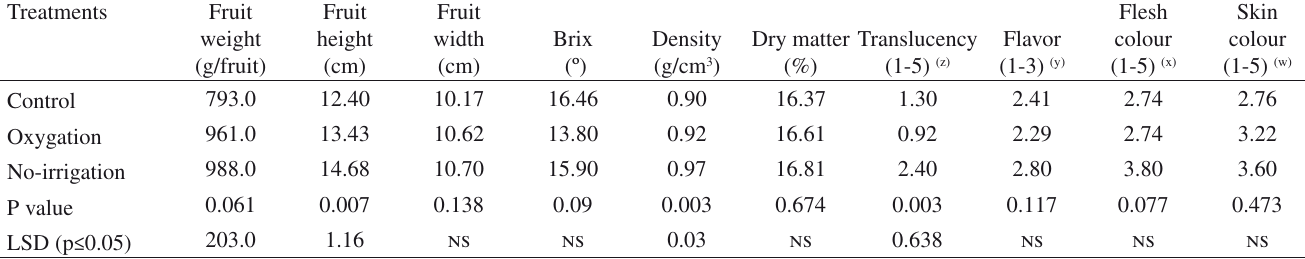
Table 10 - Fruit characteristics and quality parameters of pineapple as affected by irrigation treatments in the ratoon crop Treatments Fruit